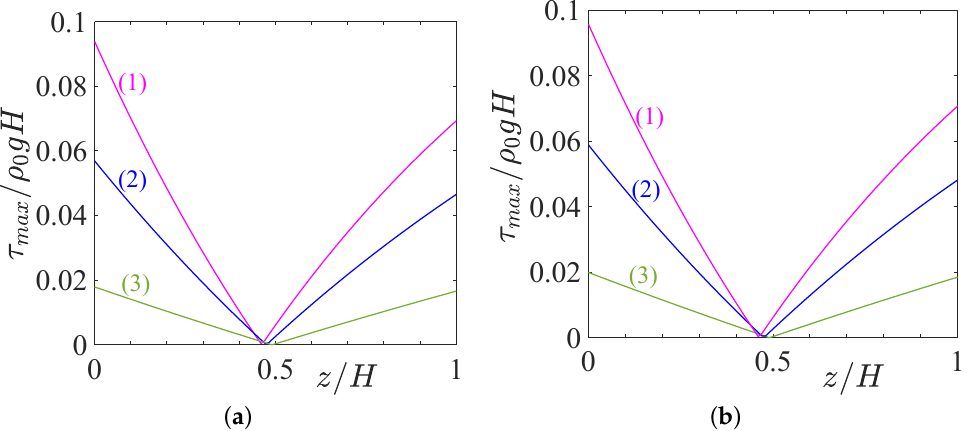
Figure 4. Variation of τ max / ρ 0 gH as a function of z / H for different triplets ( κ , Λ , Ψ ) . ( a ) (1): ( 0.0204, 1.092, 0.849 ) , (2) ( 0.0340, 1.652, 1.416 ) and (3): ( 0.102, 4.477, 4.247 ) . ( b ) Same parameters Λ and Ψ with κ =